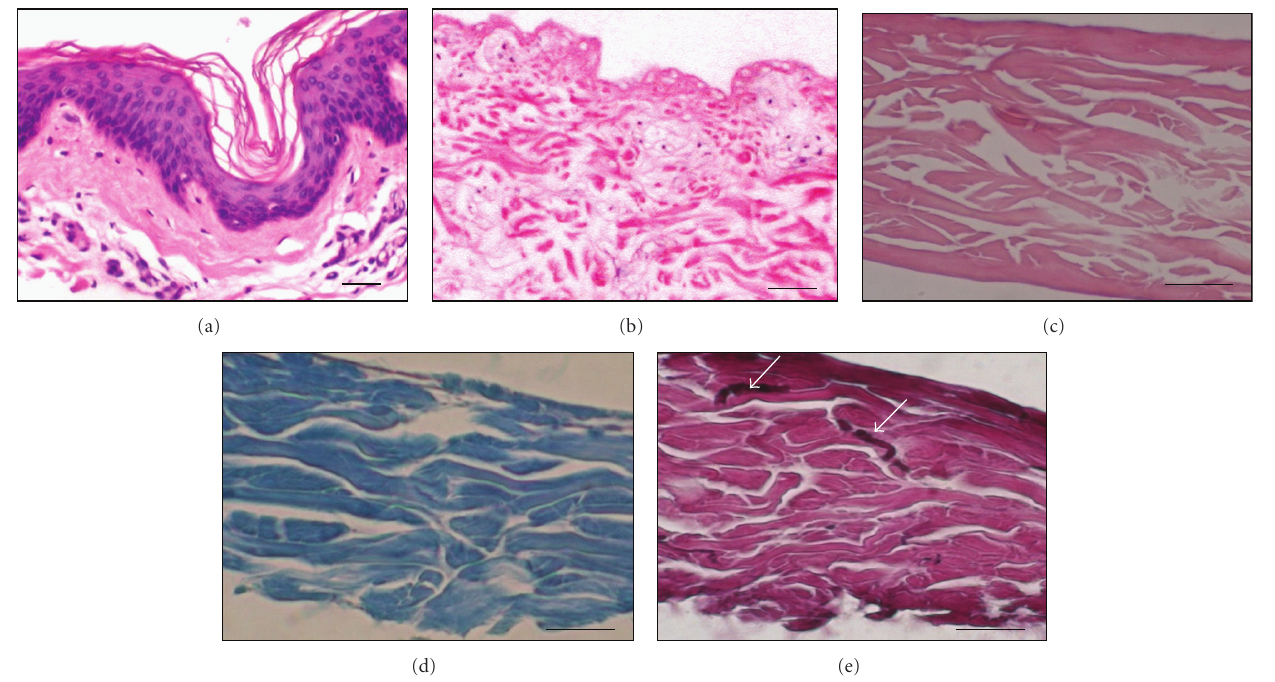
Figure 3: Structure of XD. Histological sections of (a) porcine skin, (b) acellular xenodermis immediately after removal of epidermis and other cells, (c) XD (hematoxylin and eosin), (d) XD stained with trichrome shows the majority of collagen fibres (blue), (e) XD stained with